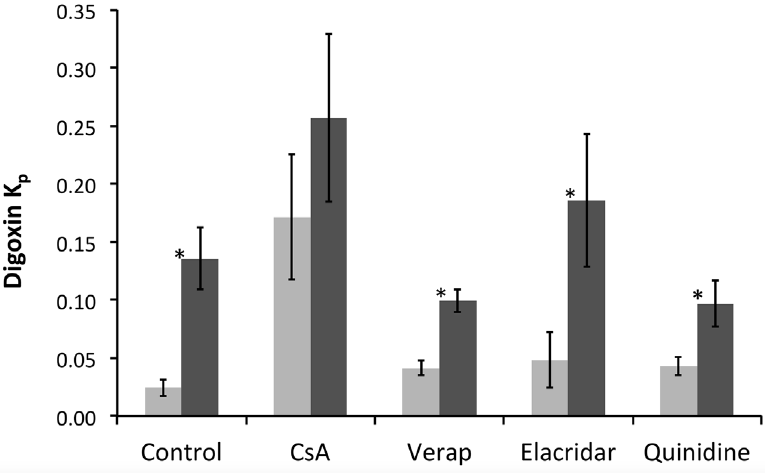
Fig 5. K p values of digoxin in C57BL/6 WT (n = 5 for each group) (grey bars) and hMDR1 mice (n = 5) (black bars) in the presence of different blockers ( * p < 0.05). Digoxin was administered subcutaneously at a dose of 1 mg/kg. P-gp blockers were given as cyclosporine A 100 mg/kg intraperitoneally, quinidine 50 mg/kg intraperitoneally, verapamil 3 mg/kg subcutaneously or elacridar 3 mg/kg subcutaneously, one hour before the digoxin administration.